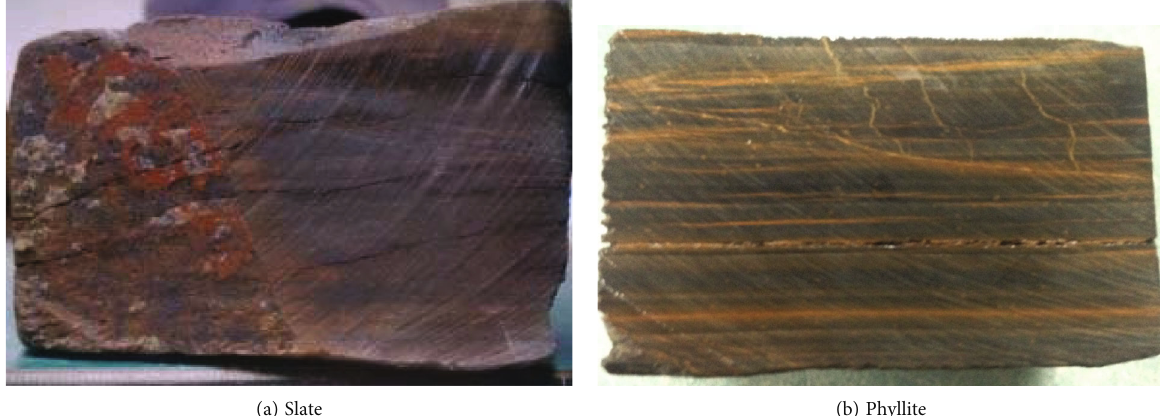
Figure 5: Variation of morphological at 30 F-T cycles of two low-grade metamorphic rocks.